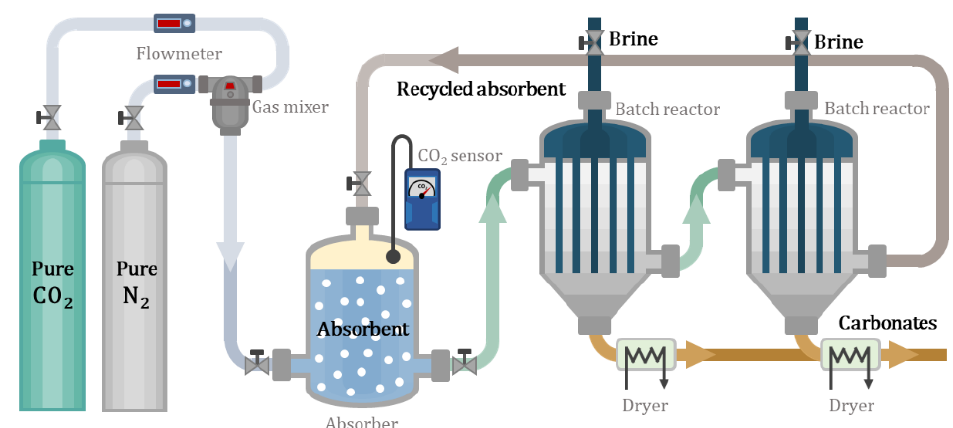
Figure 1. Experimental equipment used for multicycle IAM.